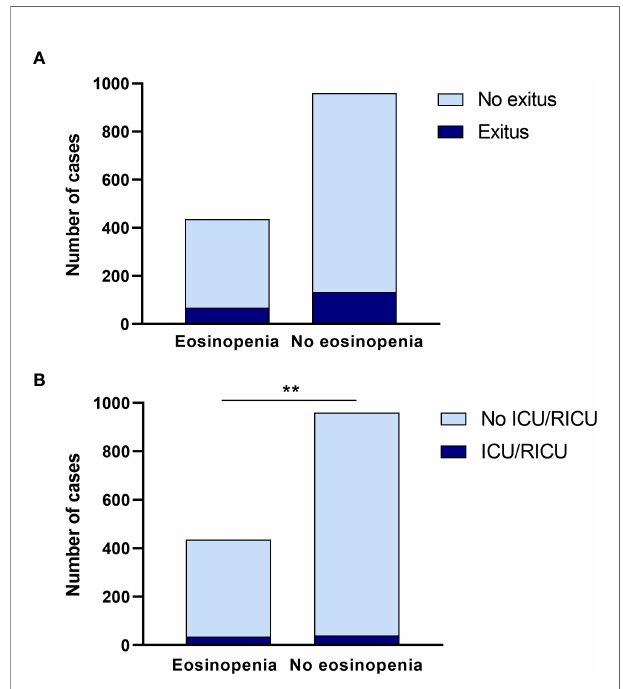
FIGURE 1 | Eosinopenia can predict ICU/IRCU admission. (A) Eosinopenia on admission did not change signi fi cantly in regards to observed mortality in either group. (B) When the need for ICU/RICU admission was assessed, patients with eosinopenia on admission had a signi fi cantly higher risk in comparison to patients with no eosinopenia on admission. ** p < 0.01.